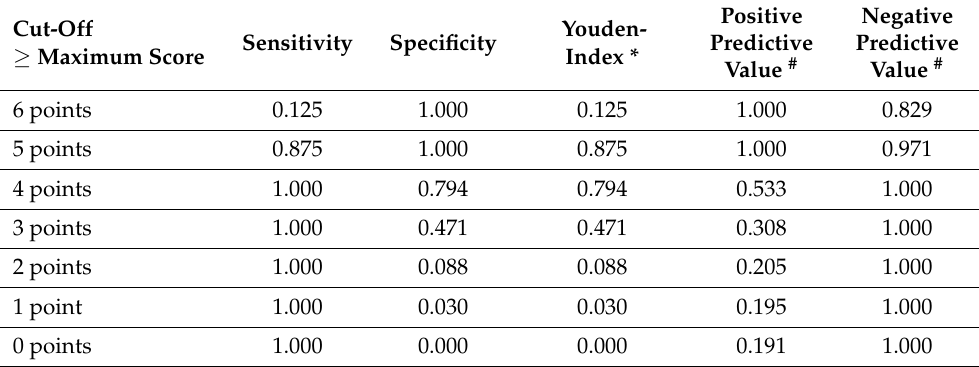
Table 4. Sensitivities, specificities, Youden-indices, positive predictive values (pneumonitis), and negative predictive values (no pneumonitis) of the different scores ranging between 0 and 6 points. Cut-Off Sensitivity Specificity ≥ Maximum Score